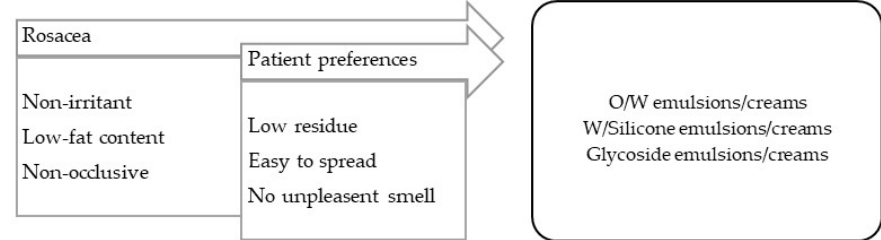
Figure 4. TPP for formulations for rosacea treatment and most suitable vehicles/bases.